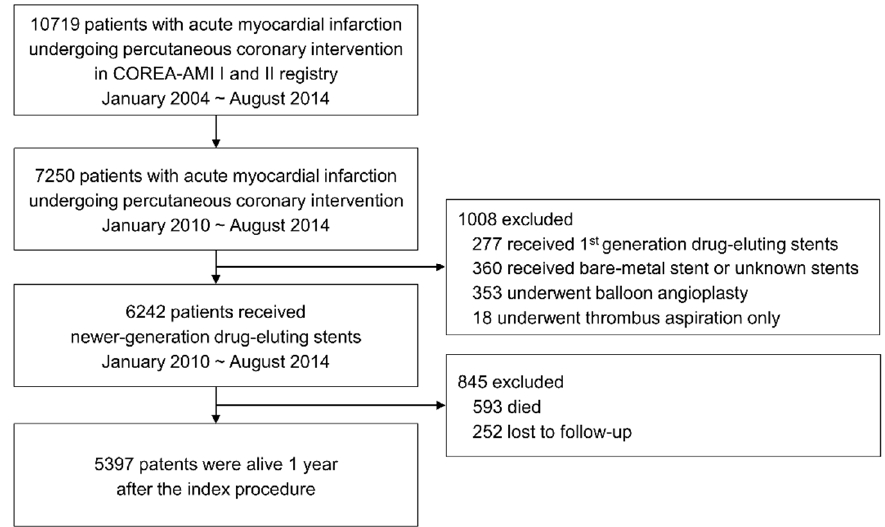
Figure 1. Study flow